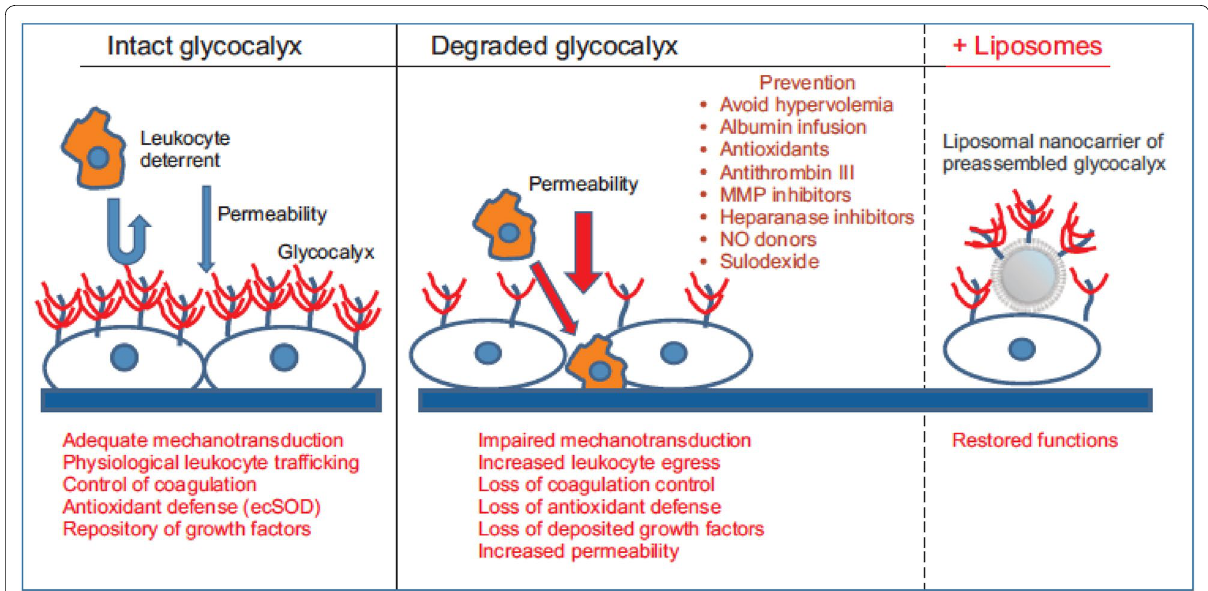
Fig. 4 Pathologies/interventions associated with glycocalyx alterations. Reproduced with permission from [10]. ecSOD extracellular superoxide dismutase; MMP matrix metalloprotease; NO nitric oxide. Sulodexide is a highly purified glycosaminoglycan mixture of low molecular weight heparin plus dermatan sulfate